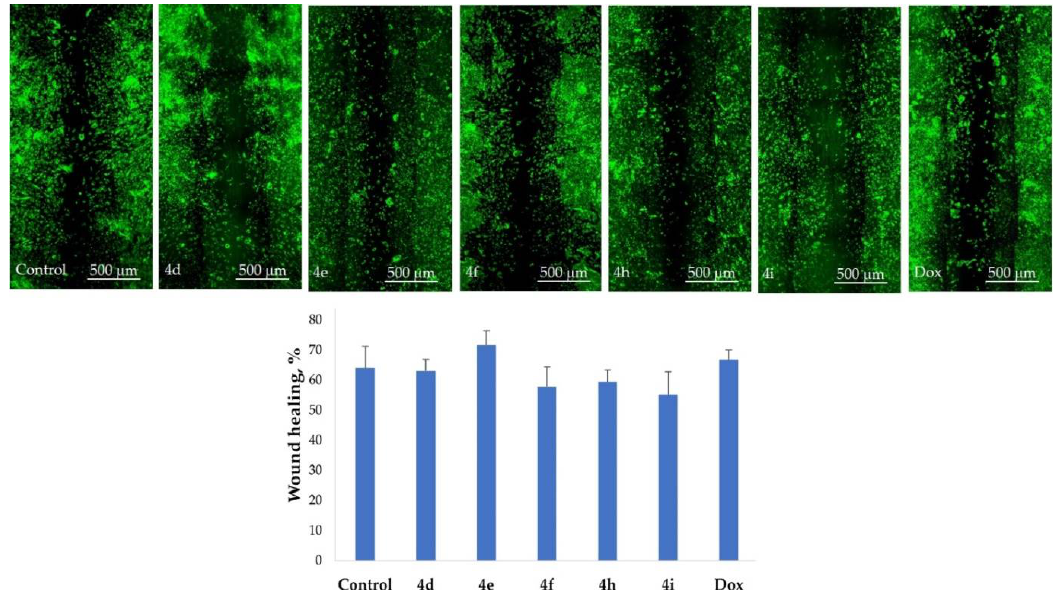
Figure 12. Microscopic images of the CT26 cells wound area in the scratch assay and wound area (%) in the scratch assay after 24 h incubation post azaspiro[bicycle[3.1.0]hexane-2,5′-pyrimidines] 4 treatment. Bars indicate  SD; * p value < 0.05.